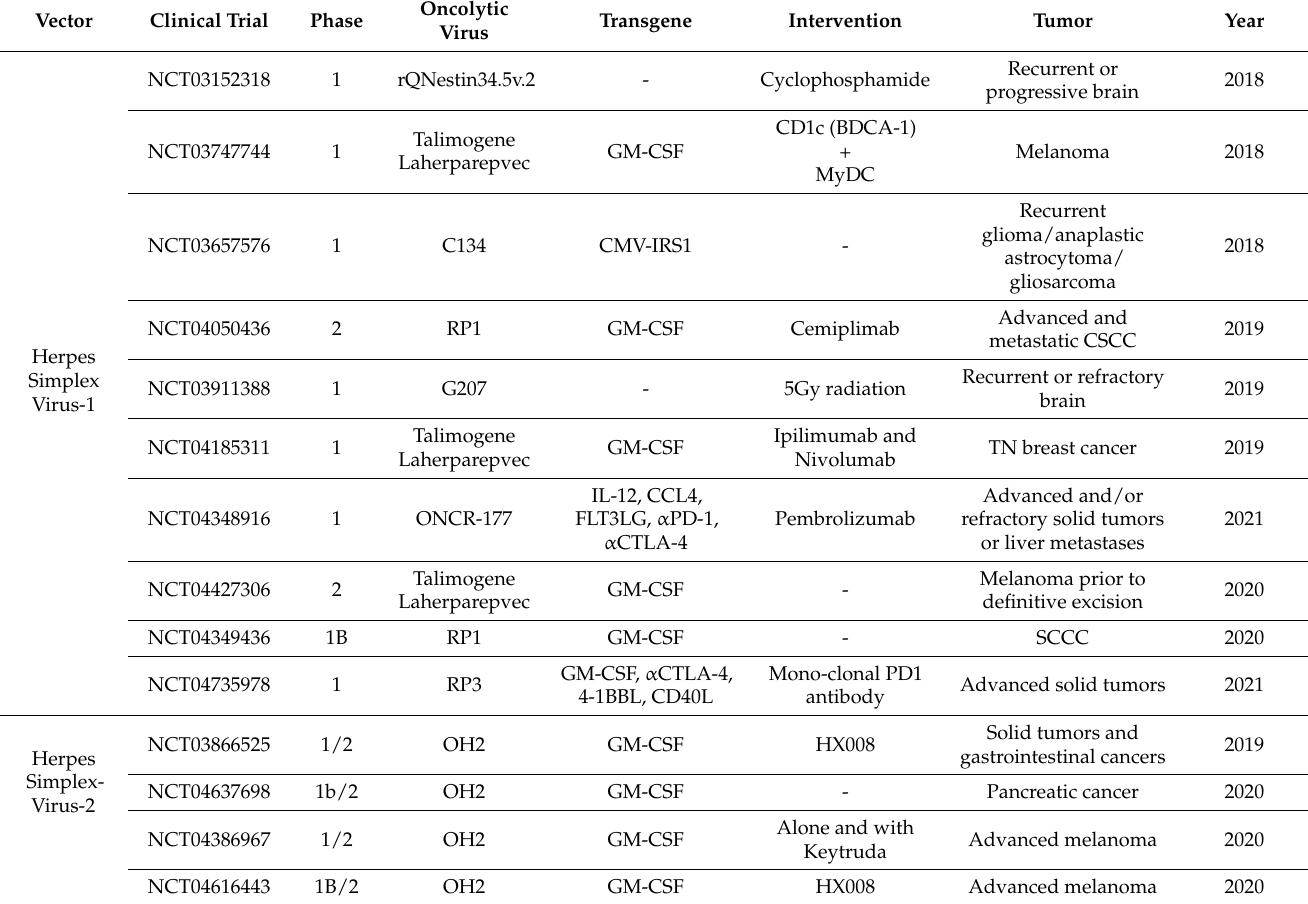
Table 1. Oncolytic Viruses in Clinical Trial. CSCC (cutaneous squamous cell carcinoma), TN breast cancer (triple-negative), CRC (colorectal cancer), NSCC (non-small cell carcinoma), NIS (sodium iodide symporter), rluc (renilla luciferase), β -gal (beta-galactosidase), β -gluc (beta-glucocordinase), FCU1 (fusion protein of cytosine deaminase and uracilphosphoribosyl-